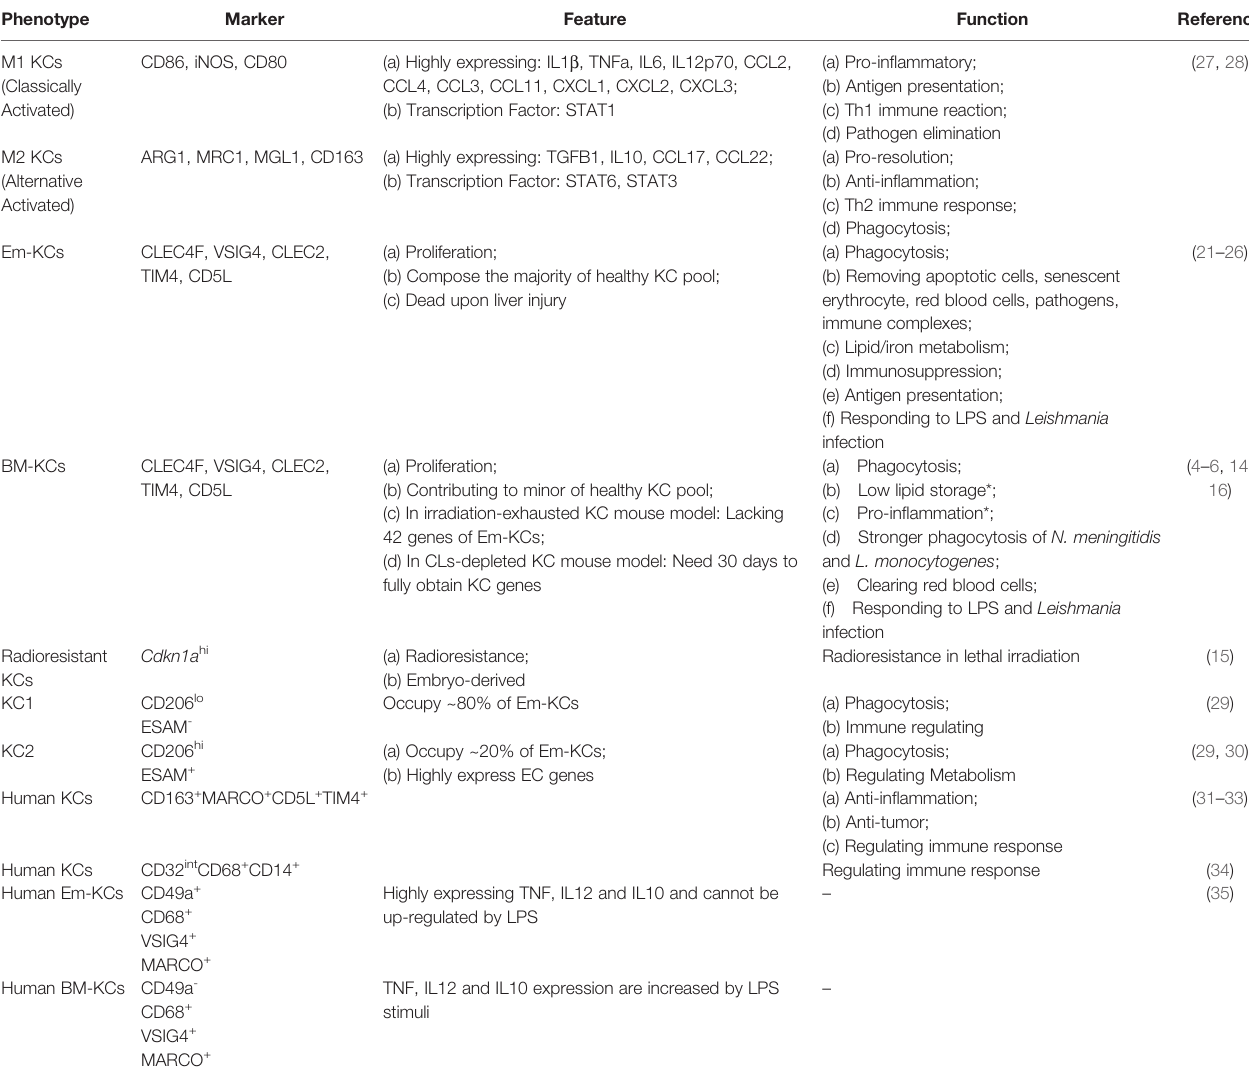
TABLE 1 | KC heterogeneity and function in